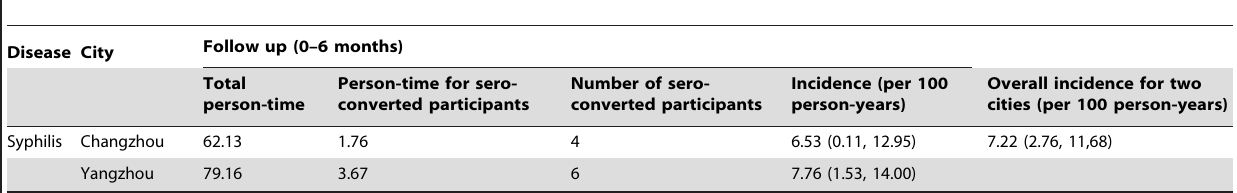
Table 2. Syphilis incidence rates among heterosexual male attendees of STI clinics (MSC) in Changzhou and Yangzhou cities of Jiangsu Province, China, during